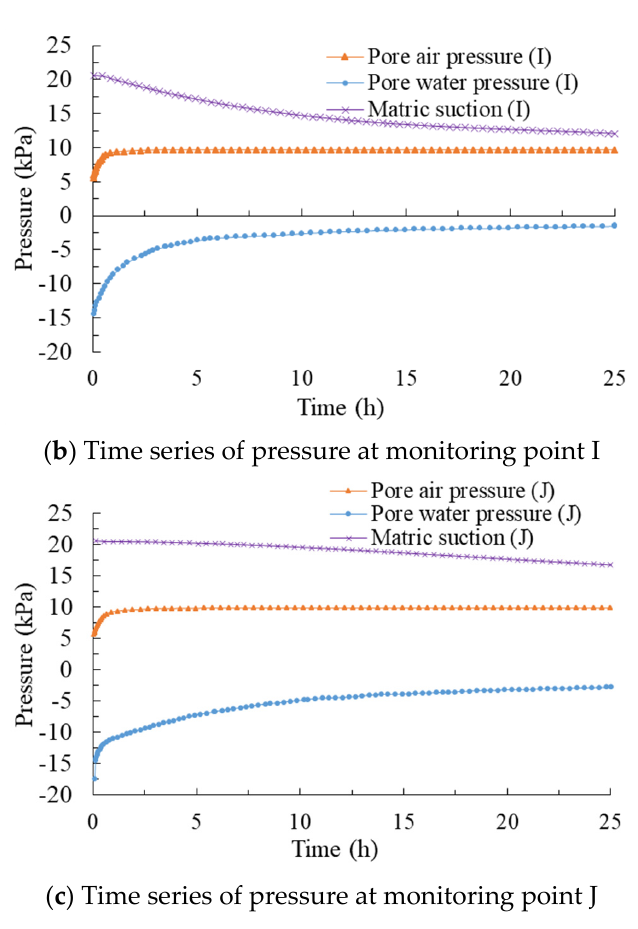
Figure 7. Time series of pressures at three monitoring points (H, I, J). The gas relative permeability coefficient of the sliding bed was much larger than the sliding body; pore gas decayed along the direction of the sliding bed. The variation of pore gas pressure over depth at the slope D-D’ section is shown in Figure 8.